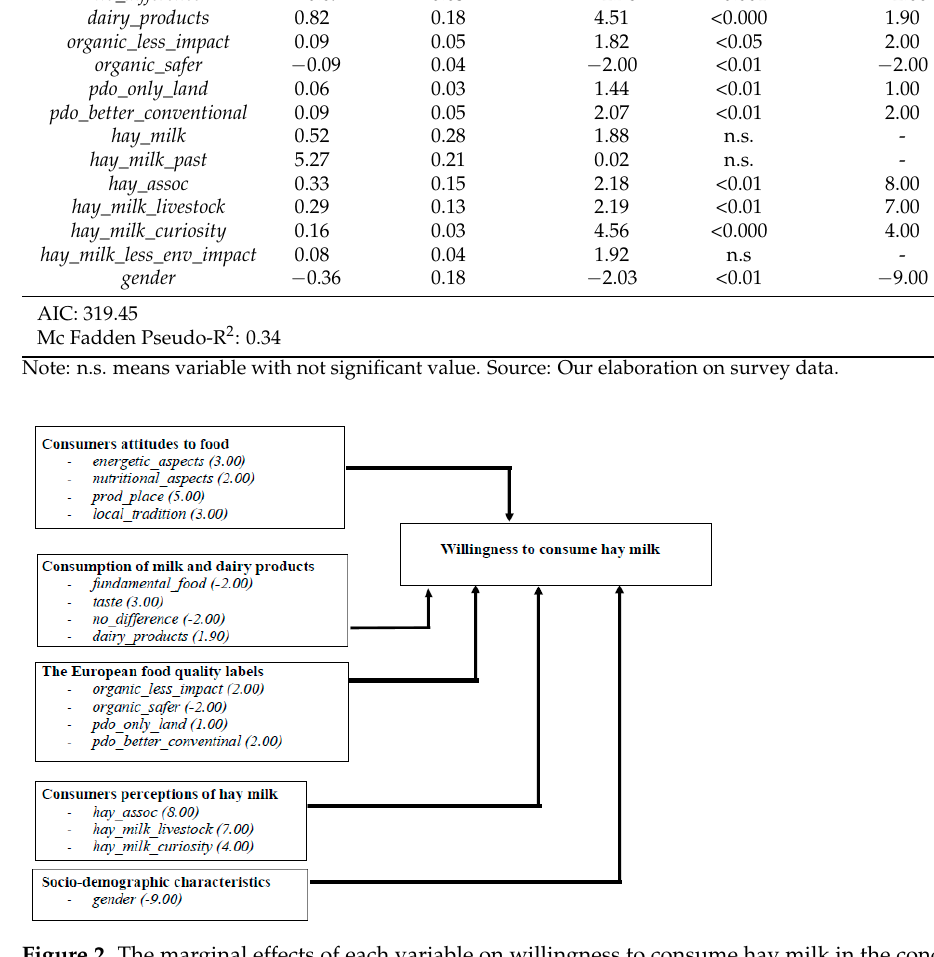
Figure 2. The marginal effects of each variable on willingness to consume hay milk in the conceptual framework.